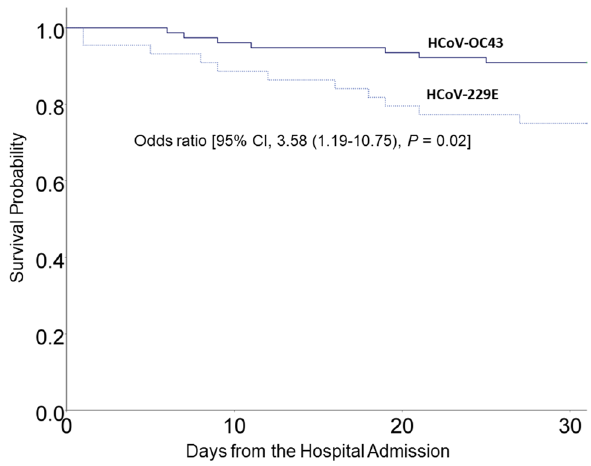
Figure 3. Kaplan–Meier survival curves of 121 adults hospitalized with human coronavirus 229E (dotted line) and OC43 infections (solid line). Patients with HCoV 229E infection had a lower survival rate than those with HCoV OC43 infection. The crude 30-day mortality among patients with human coronavirus 229E and OC43 infections was 25.0% and 9.1%, respectively.